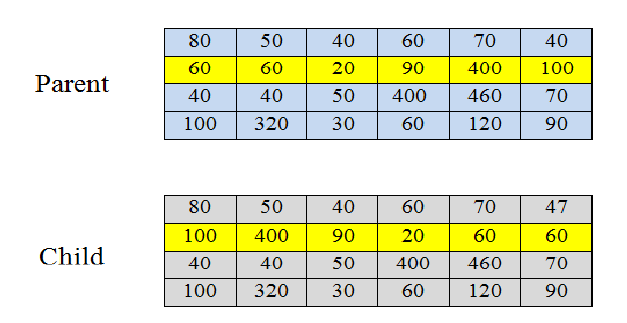
Fig. 3. Reverse mutation operator.